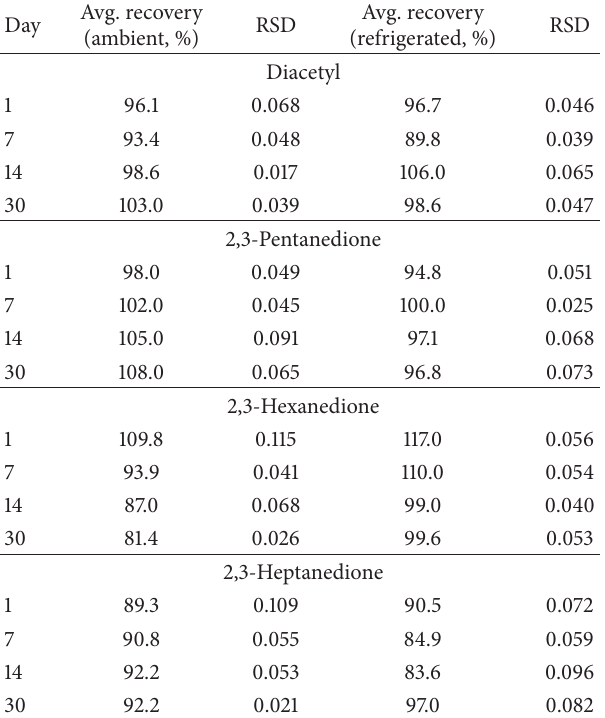
Table 13: Storage stability conducted under ambient and refriger- ated storage